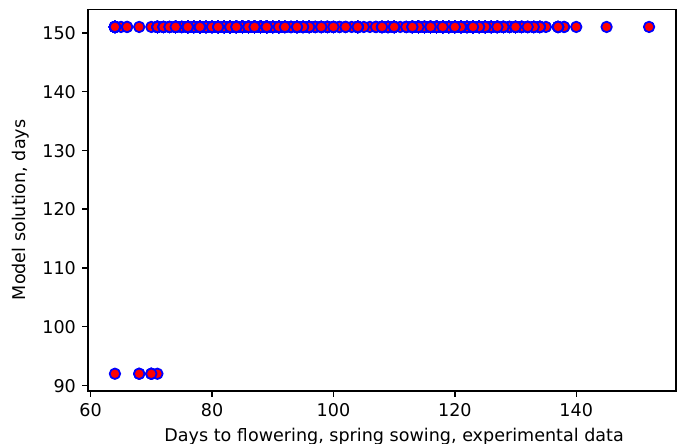
Figure 5. Typical model solution for flowering time data for spring sowing. The time numerical limit of 152 days is predicted for most